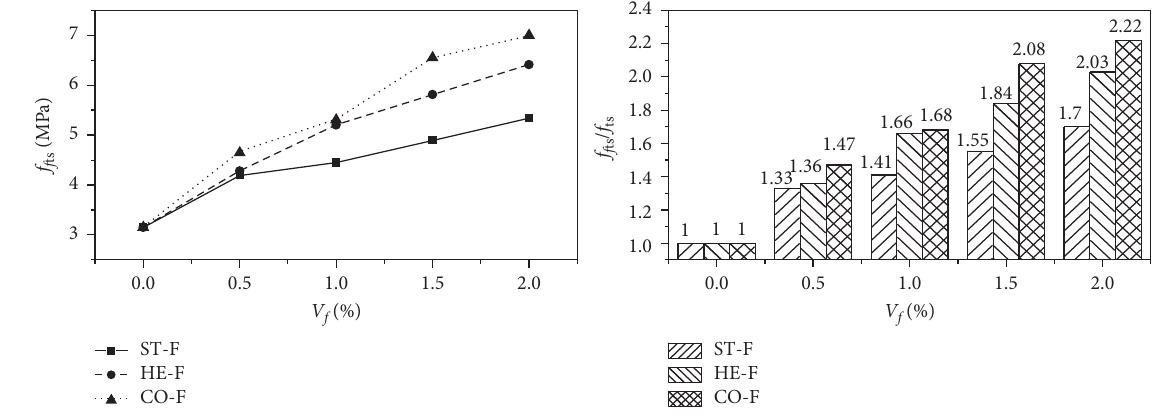
Figure 5: Relationship between f